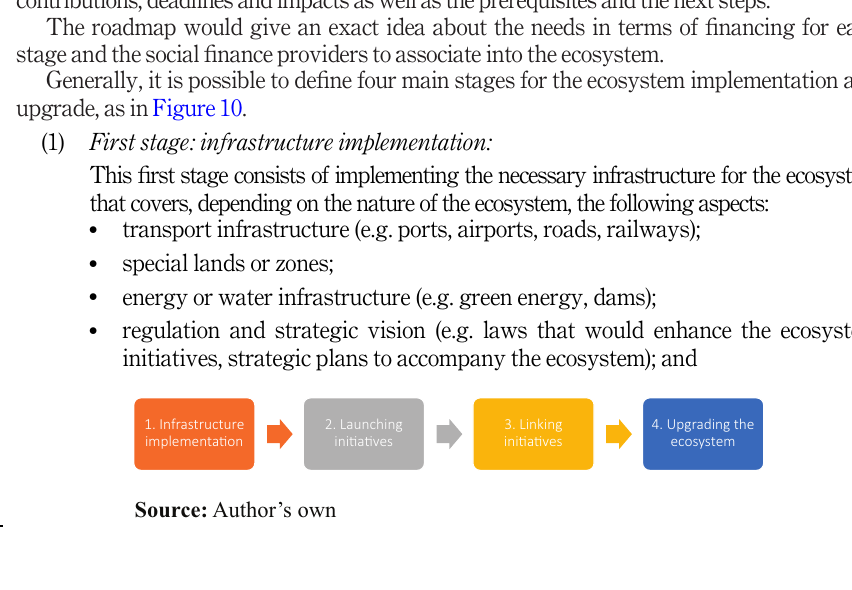
Figure 10. Main stages for the ecosystem